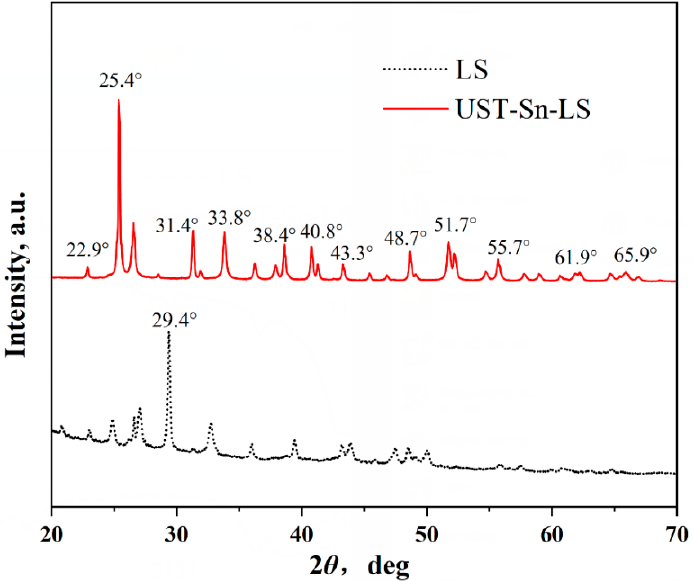
Figure 3. XRD characterization of raw LS and UST-Sn-LS. The 2 θ angle was scanned between 20° and 70°.